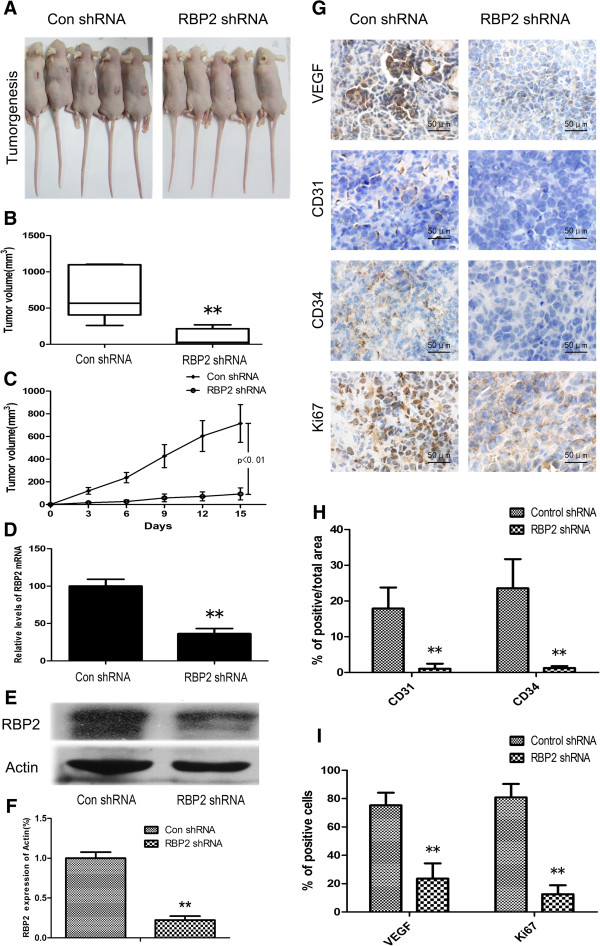
Inhibition of VEGF expression and angiogenesis by RBP2 knockdown in nude mice. (A) Tumorgenesis after injection of BGC-823 cells stably expressing RBP2 shRNA and control shRNA. (B) Tumor volume with RBP2 shRNA stable expression and controls. Data are median, with box edges as interquartile range and whiskers as the minimum and maximum values. **P < 0.01. (C) Growth curve with RBP2 shRNA stable expression and controls. **P < 0.01. (D) QRT-PCR analysis of RBP2 mRNA expression with RBP2 shRNA stable expression and controls. **P < 0.01 (E, F) Western blot analysis of RBP2 protein expression with RBP2 shRNA stable expression and the control. **P < 0.01. (G) Immunohistochemical staining for VEGF, CD31, CD34 and Ki67 in the control group (left panel) and RBP2 shRNA stable expression group (right panel). Representative images are shown. (H) Percentage positive area for CD31 and CD34 expression with the control and RBP2 shRNA stable expression determined immunohistochemically. **P < 0.01. (I) Percentage positive cells for VEGF and Ki67 with the control and RBP2 shRNA stable expression determined immunohistochemically. **P < 0.01.